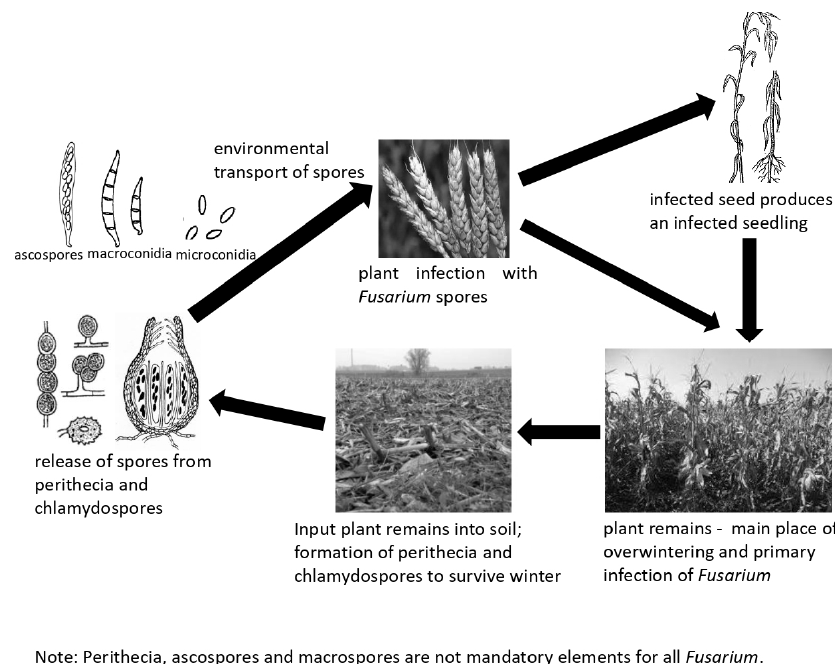
Figure 1. Scheme of distribution, infection, and conservation of Fusarium .